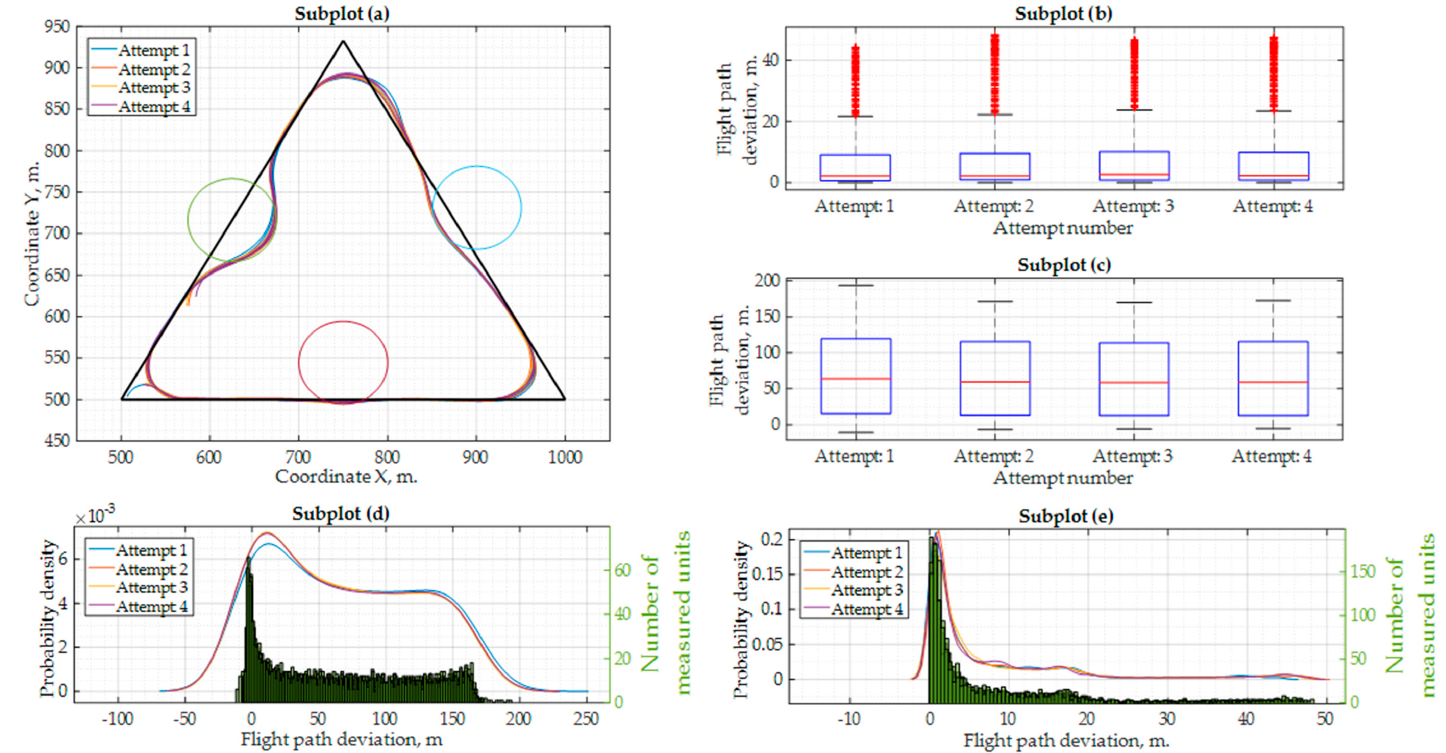
Figure 12. Results of real flight experiments with the “PX4” autopilot with the flight speed at 15 m/s and using the “Ublox Neo-M8N” GNSS receiver: ( a ) flight mission, flight trajectory and ground obstacles; ( b ) flight deviation from the standard flight mission path (when using ground obstacle avoidance); ( c ) flight deviation from the ground obstacle area boundary of 50 m. (when using ground obstacle avoidance); ( d ) probability density values and quantity of measurements for every flight path deviation value (standard mission); ( e ) probability density values and quantity of measurements for every flight path deviation value (from ground obstacle area